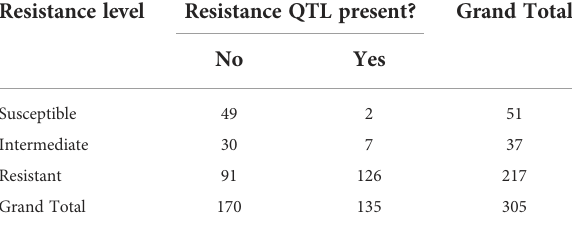
TABLE 4 Numbers of clones at different levels of resistance and whether a QTL for resistance to red rot was putatively present. Resistance level